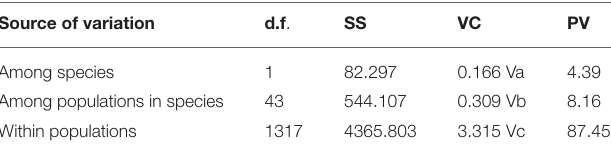
TABLE 2 | Analyses of molecular variance (AMOVA) in Sibiraea based on 8 SSR loci. Source of